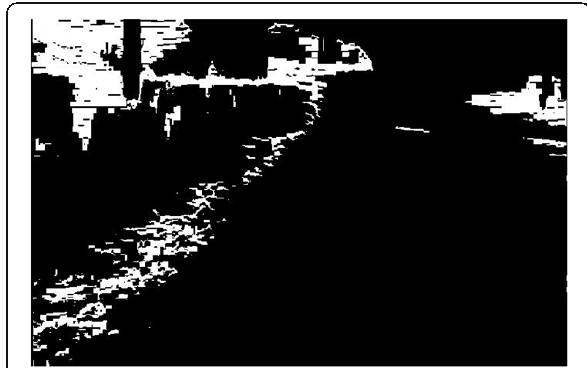
Fig. 3 Segmentation map based on double-Otsu method